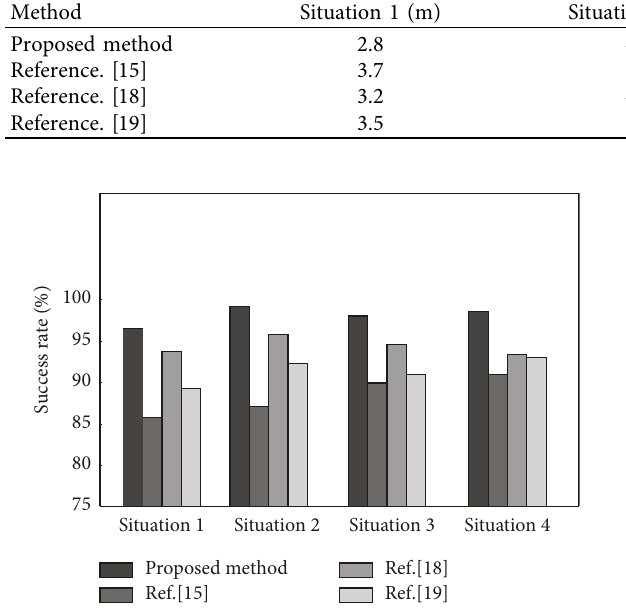
Figure 7: The success rate of path planning of different methods in different